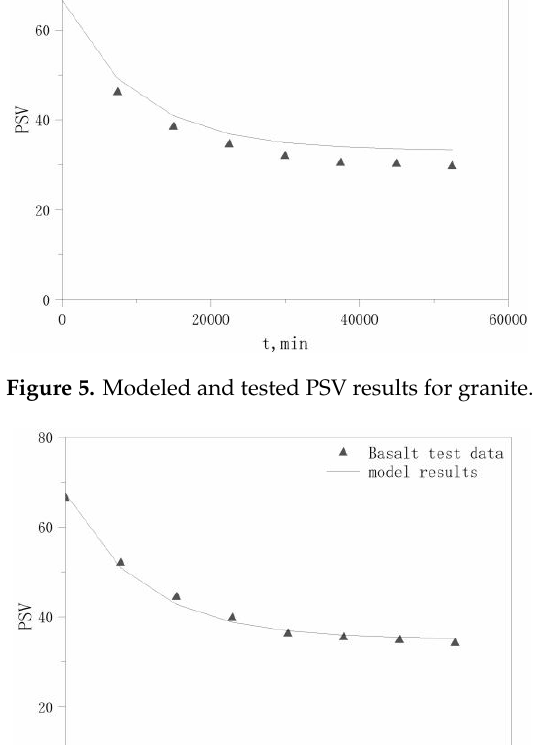
Fig. 7 Modeled and tested PSV results for limestone. Figure 6. Modeled and tested PSV results for